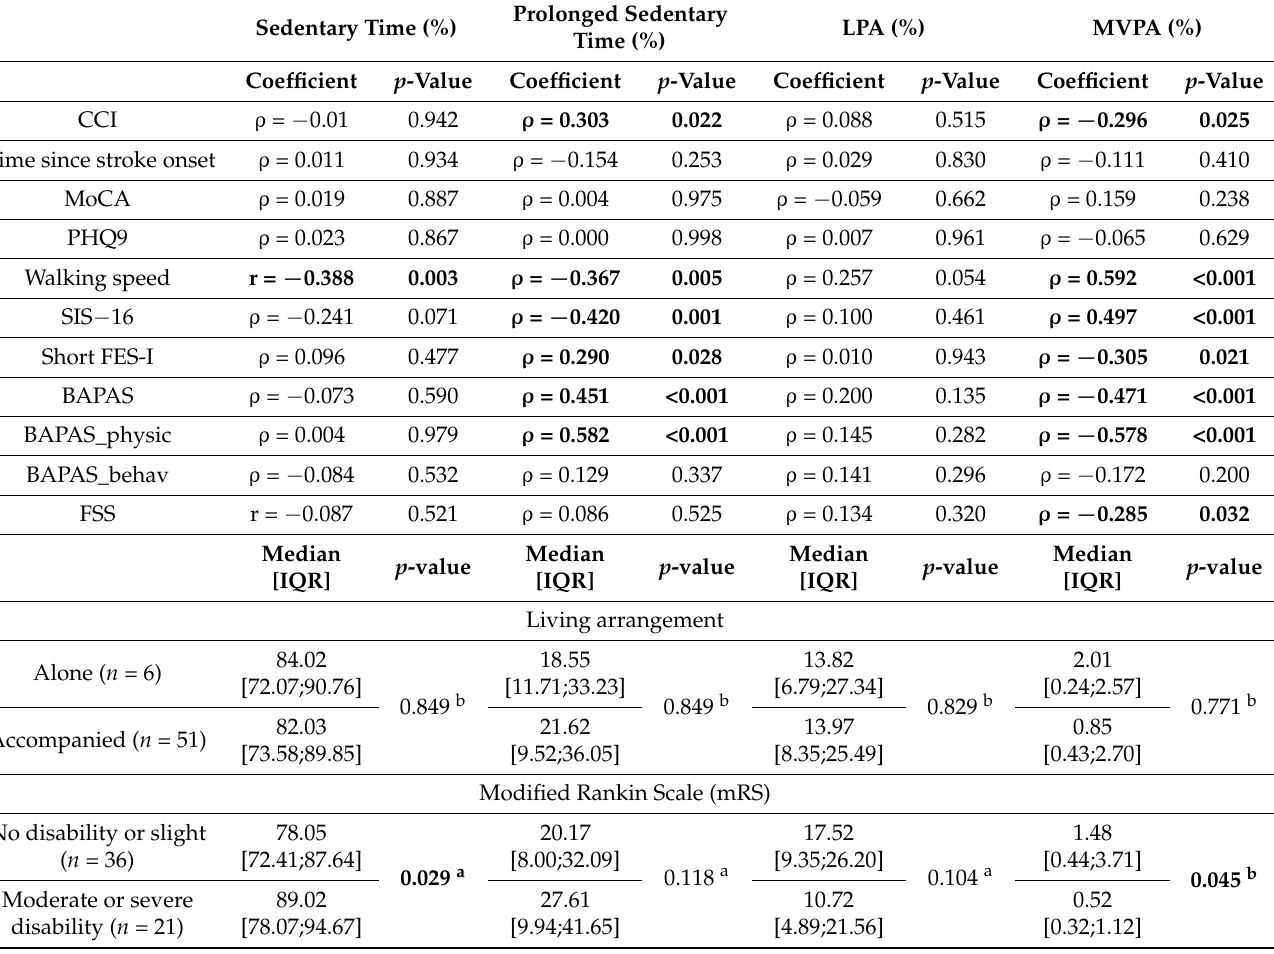
Table 3. Factors influencing the sedentary behavior and physical activity—correlation analyses and differences in dichoto- mous variables ( n =